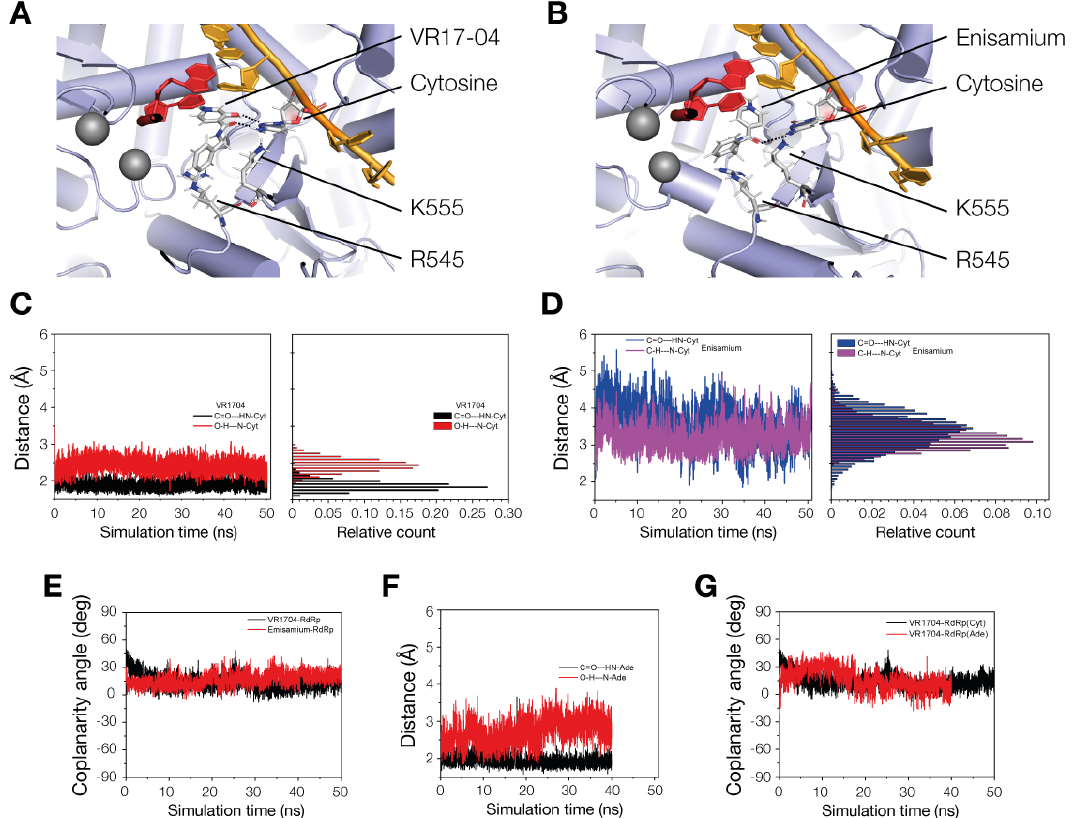
Figure 5. MD simulations of VR17-04 binding to nsp12/7/8. ( A ) MD simulation snapshot of VR17-04 binding to cytosine in nsp12 active site. Black dotted lines indicate hydrogen bonds. Template is shown in bright orange and nascent strand in dark red. Grey spheres represent magnesium ions. Positive charges on amino acids and base are dark blue and negative charges light red. Nsp12 is colored light blue and shown in a cartoon presentation. ( B ) MD simulation snapshot of enisamium binding to cytosine in nsp12 active site. Colors as in Figure 5A. ( C ) MD simulation plot of hydrogen bond distances during VR17-04 binding to cytosine in nsp12 active site (left) and histogram of hydrogen bond distances (right). ( D ) MD simulation of hydrogen bond distance (C=O—HN-Cyt, blue color) during enisamium binding to cytosine in nsp12 active site. Since no second hydrogen bond can form in the case of enisamium binding to nsp12/7/8, the distance C-H—HN-Cyt is reported in magenta color for comparison. ( E ) MD simulation plot of the coplanarity angle of VR17-04 or enisamium binding to cytosine in nsp12 active site. ( F ) MD simulation of hydrogen bond distances during VR17-04 binding to adenine in nsp12 active site. ( G ) MD simulation of coplanarity angle of VR17-04 binding to cytosine or adenine in nsp12 active